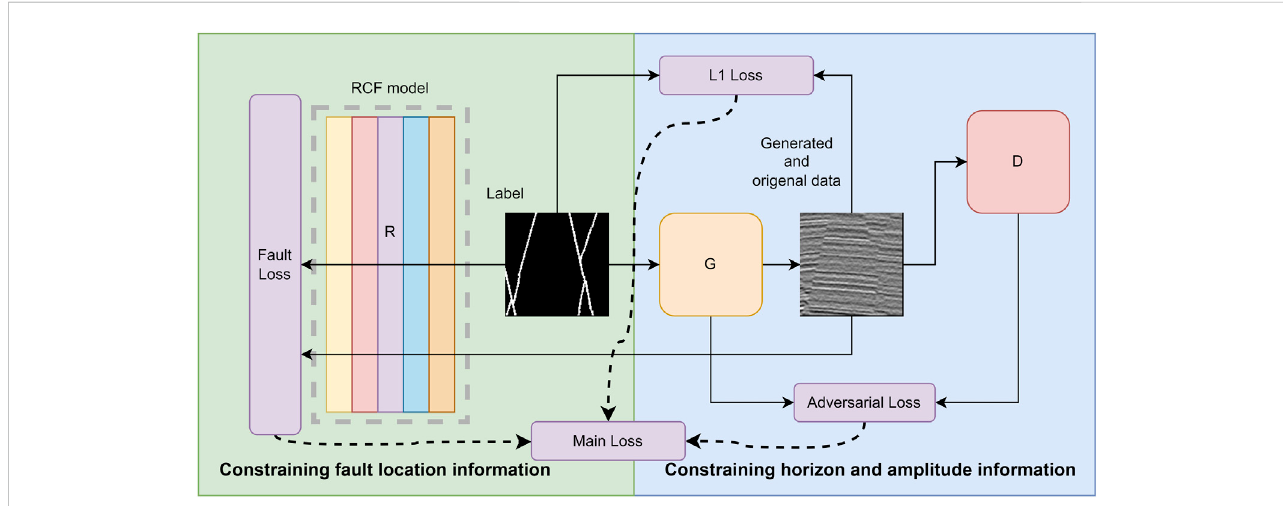
FIGURE 1 Fault2SeisGANroadmap.Fault2SeisGANtransformsthefaultlabelsbylearningthemappingrelationshipbetweentheseismicamplitudedatadistribution p seis ( X | θ ) and location of the fault